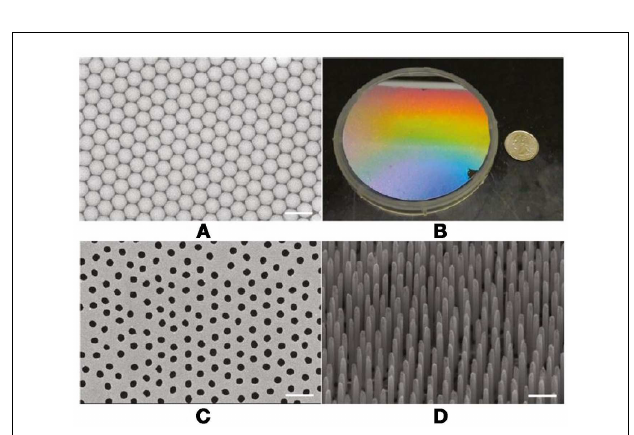
FIGURE 9 | SEM image of PS microsphere array (A) showing well-ordered structure in microscale . Optical image of a 4 (cid:48)(cid:48) wafer (B) , showing uniform PS array. Au-coated patterned Si substrate defined by areas not previously covered by the plasma-etched microspheres (C) . Slight disordering is induced during the plasma etching process. Au-coated region becomes a catalytic site during metal-assisted electroless etching, which results in well-defined vertical SiNW structures (45° tilt view) (D) . Scale bar = 2 µ m in all SEM images. From Lee et al. (2011).